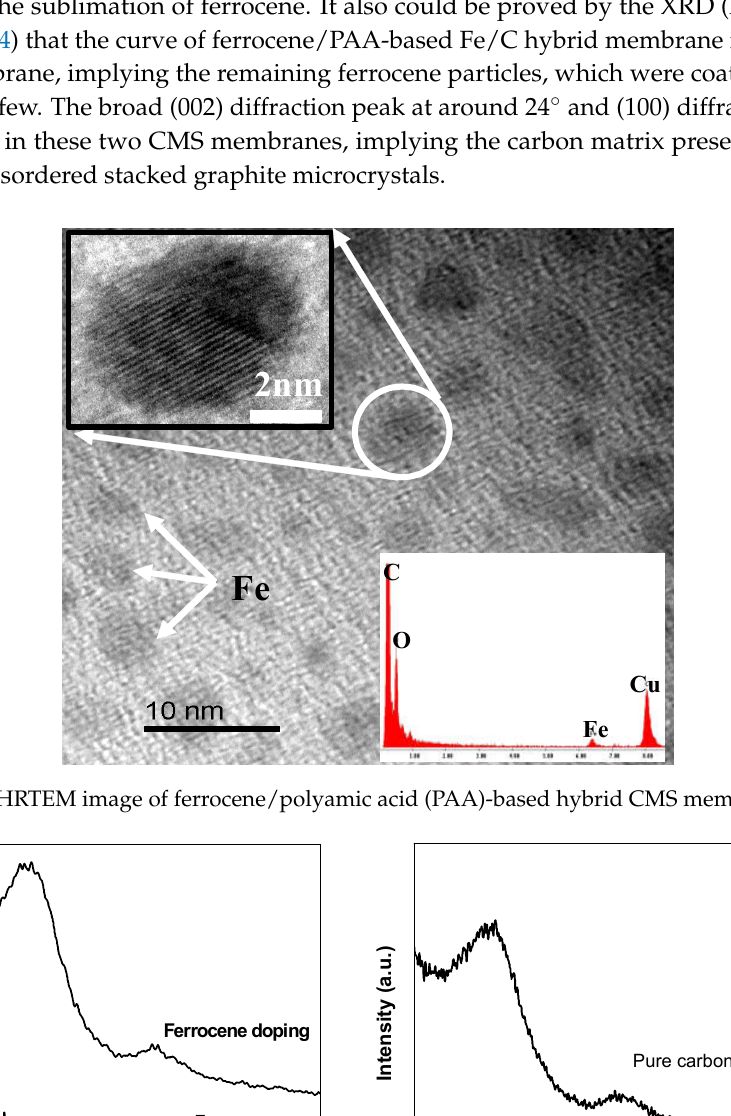
Figure 4. XRD patterns of ferrocene/PAA-based Fe/C hybrid membrane ( a ) and PAA-based pure CMS membrane ( b ) [63].